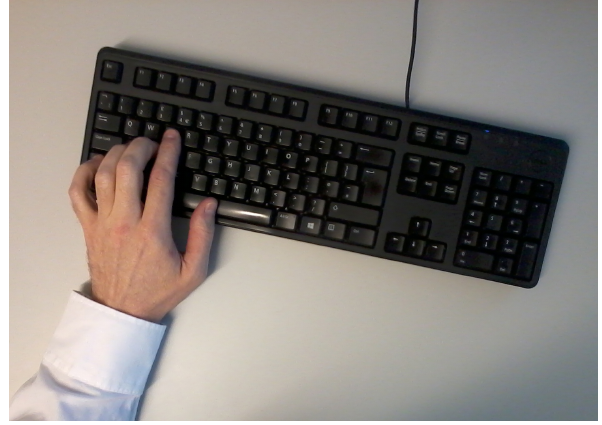
Figure 4. Hand position for the left-hand key set, with the keyboard at an angle of 10–15 ◦ to minimise finger reach